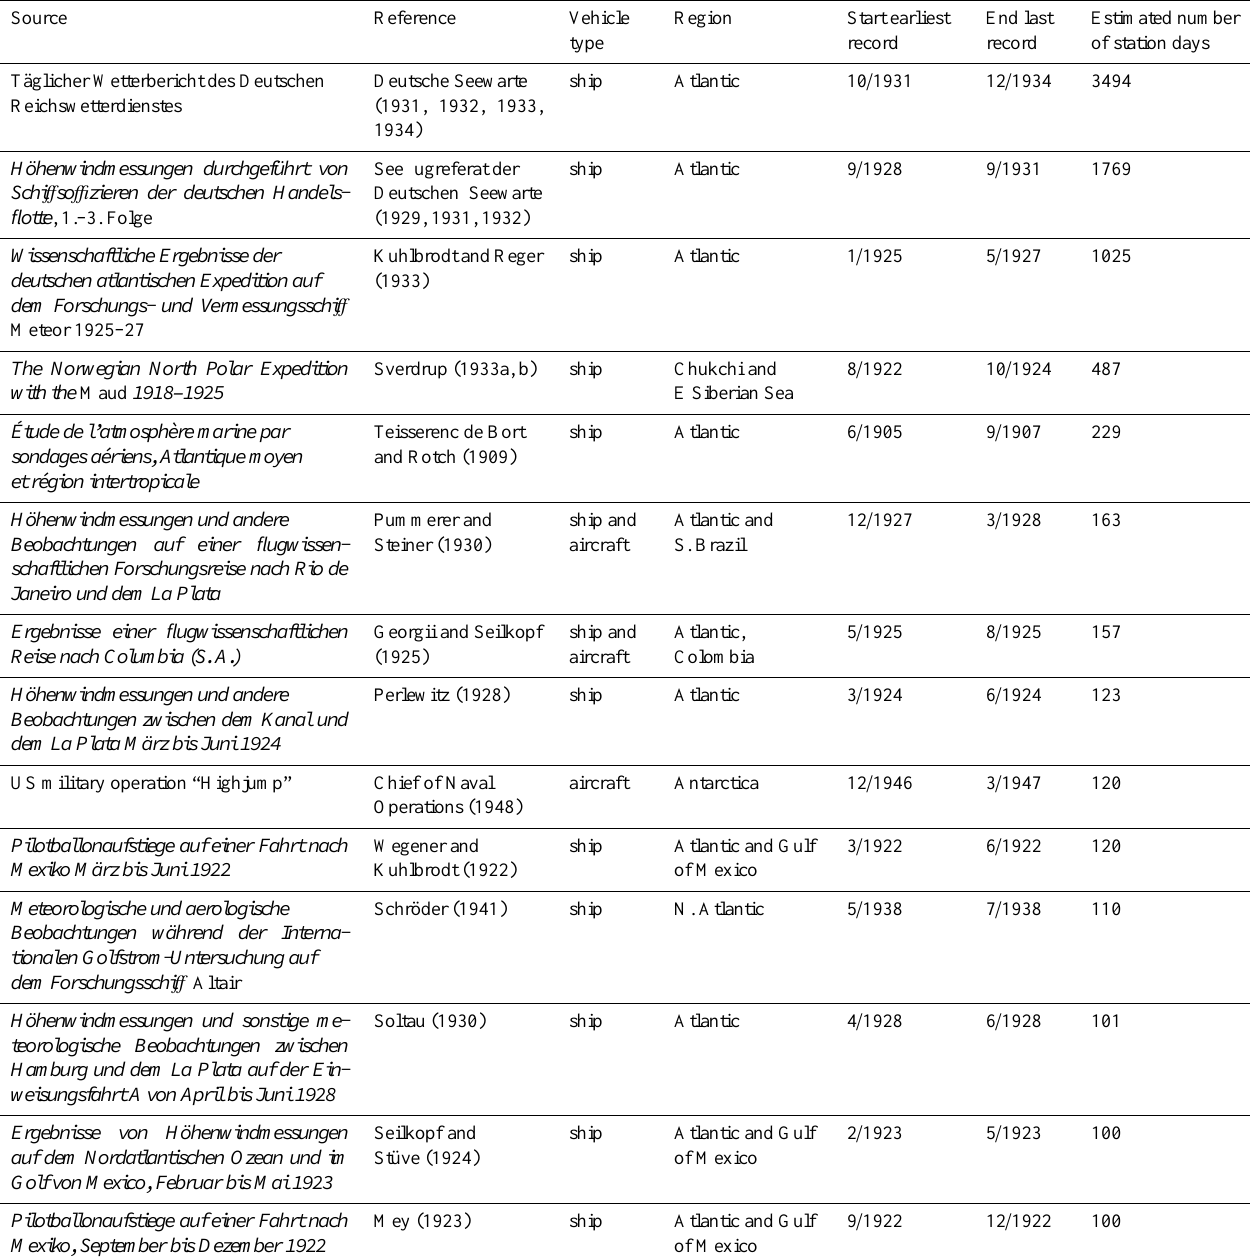
Table 2. The largest single inventoried ERA-CLIM sources of moving upper-air data ( > 100 station days).